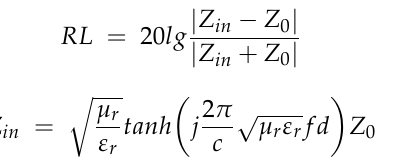
Figure 6a. The real part parameters ( ε (cid:48) and µ (cid:48) ) denote the storage abilities of electrical energy and magnetic energy, and the imaginary part parameters ( ε (cid:48)(cid:48) and µ (cid:48)(cid:48) ) represent the dissipation ability of the electromagnetic wave [27,28]. The electromagnetic loss tangent (tan δ ε = ε (cid:48)(cid:48) / ε (cid:48) and tan δ µ = µ (cid:48)(cid:48) / µ (cid:48) ) (Figure 6b), the attenuation constant ( α ) (Figure 6c), C 0 (Figure 6d), the typical Cole–Cole semicircles (Figure 6e), and the reflection loss ( RL ) curves (Figure 6f,g) are calculated according to Formulas (1)–(5) [29,30]. The mBPUF samples with a content of 30% are mixed with paraffin and BPU to make a coaxial ring and coating, respectively. The reflection loss ( RL ) depends upon the electromagnetic parameter of the materials, the thickness ( d ), the working frequency ( f ), and the velocity of the electromagnetic wave in a vacuum ( c ). These are constructed according to the transmission line theory. The calculation formulas of RL are as follows: